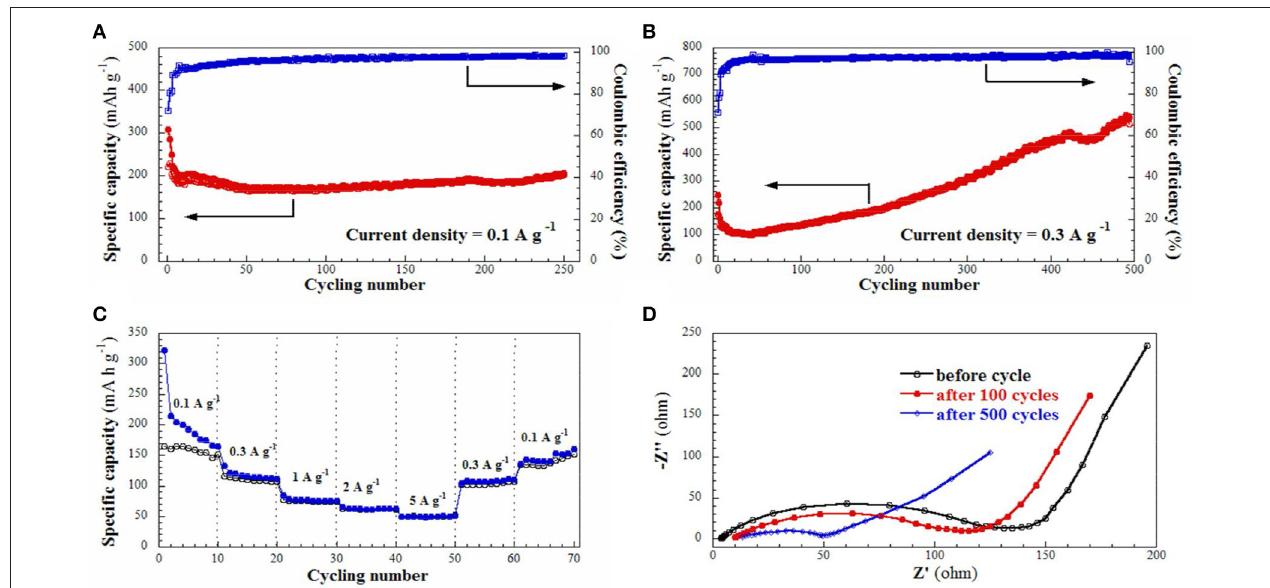
FIGURE 5 | (A,B) Cycling behavior of S2 electrodeat current density of 0.1A g − 1 and 0.3A g − 1 ; (C) Rate performance of S2 electrode at various current densities from 0.1A g − 1 to 5A g − 1 ; (D) Nyquist plot for S2 electrode in the frequency range from 100KHz to 10 MHz before and after cycling.